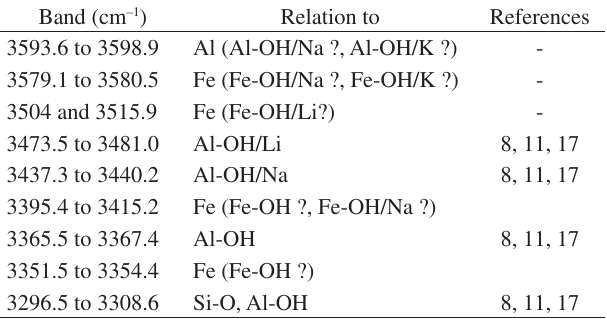
Table 3. Bands observed in the infrared spectrum of natural quartz. Band (cm –1 ) Relation to